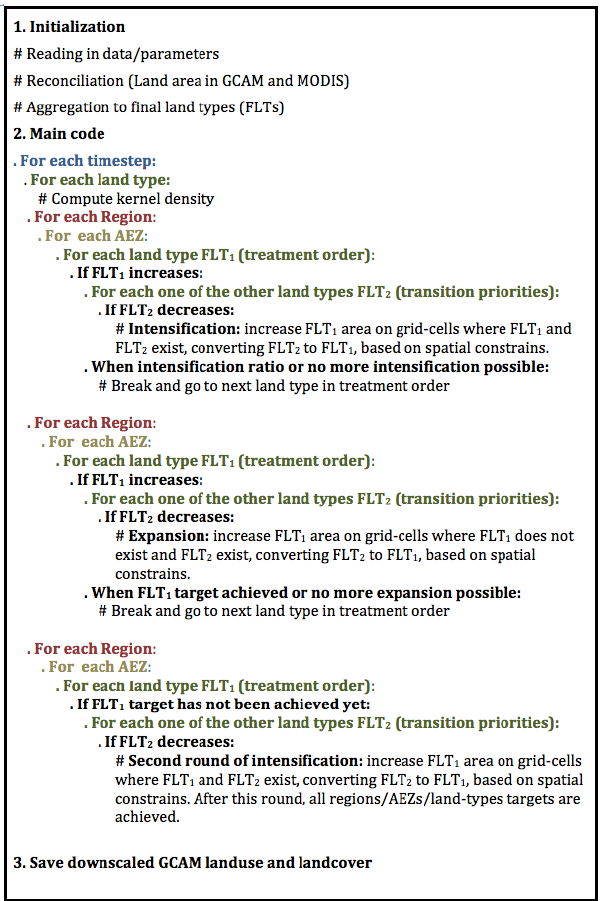
Figure 4. Computation flow of the downscaling